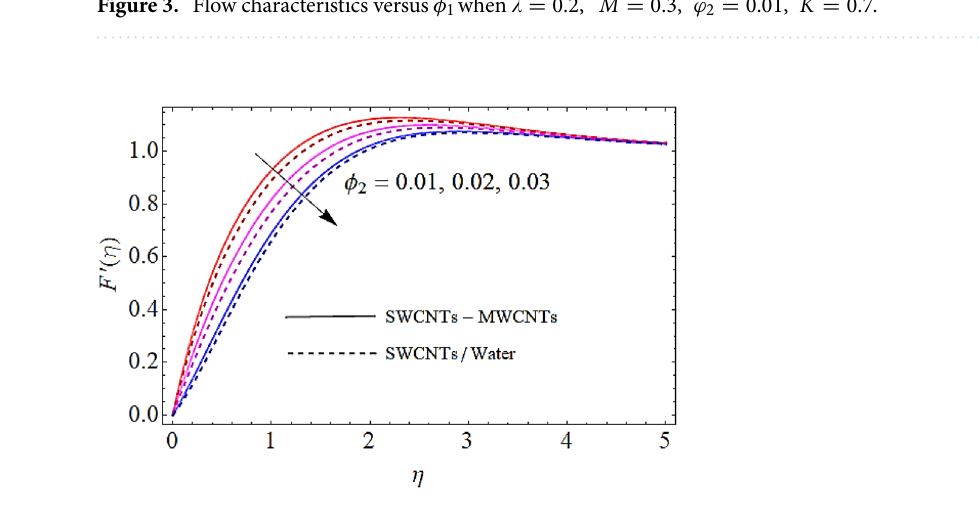
Figure 3. Flow characteristics versus φ 1 when (cid:31) = 0.2, M = 0.3, ϕ 2 = 0.01, K = 0.7 .